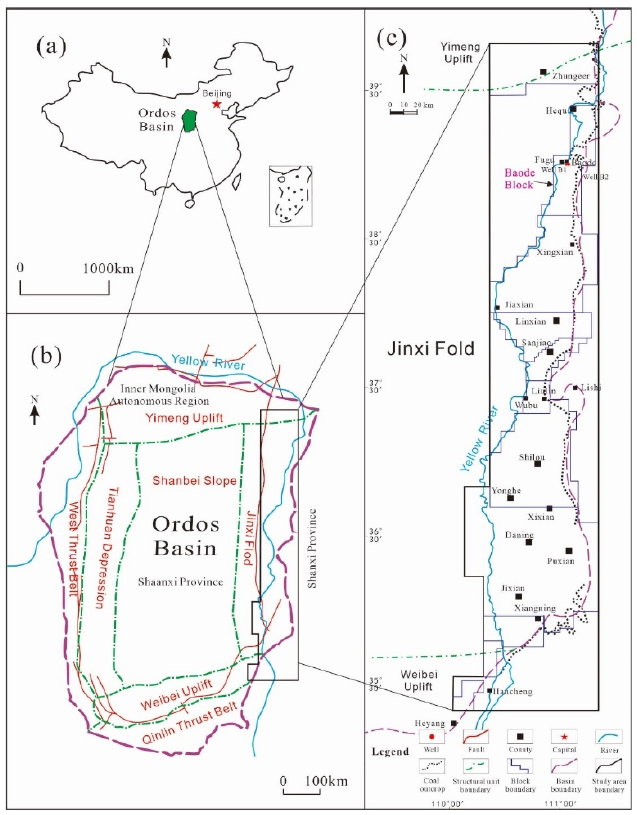
Figure 1. ( a ) Location of the Ordos Basin. ( b ) Tectonic units of the Ordos Basin. ( c ) Division of eastern margin of Ordos Basin and the location of Baode block, with the location of Wells B1 and B2. In the Baode block, the main coal-bearing sequences occur in the Upper Carboniferous Taiyuan Formation (C 3 t) and the Lower Permian Shanxi Formation (P 1 s) (Figure 2). The C 3 t is in integrated contact with the underlying strata, with a thickness of 50–90 m. It is mainly composed of black-gray mudstone, gray-white medium sandstone, gray coarse sandstone, and coal seam. A layer of bioclastic limestone is locally developed in the lower part, and the bottom is gray-white thick layered medium coarse sandstone and